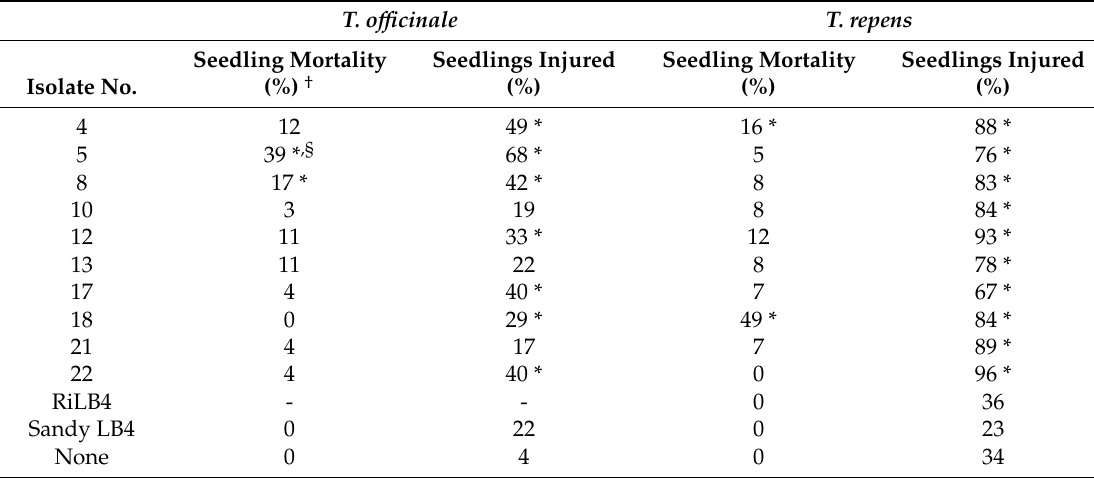
Table 2. E ff ect of bacteria collected outgrowing from surface-sterilized Digitaria ischaemum seeds on Taraxacum o ffi cinale seedling mortality 14 days after inoculation and Trifolium repens 7 days after inoculation in axenic agarose culture. Only certain isolates were evaluated based on the results of Run A. Isolates RiLB4 and Sandy LB4 (Genbank No. KX752781 and KX665565, respectively) were isolated from Phragmites australis and were included as